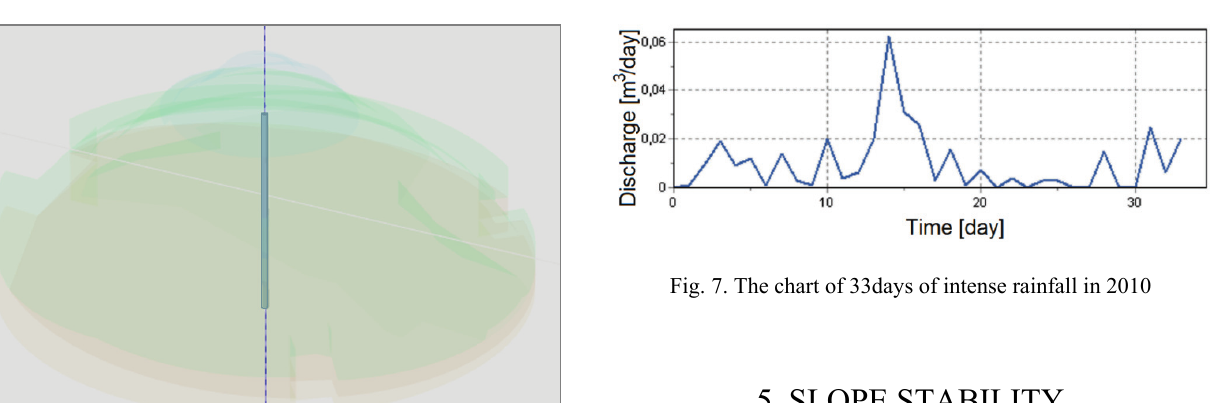
Fig. 4. Finite element mesh in Plaxis application, general view with the enlargement of the Mound area and showing the north